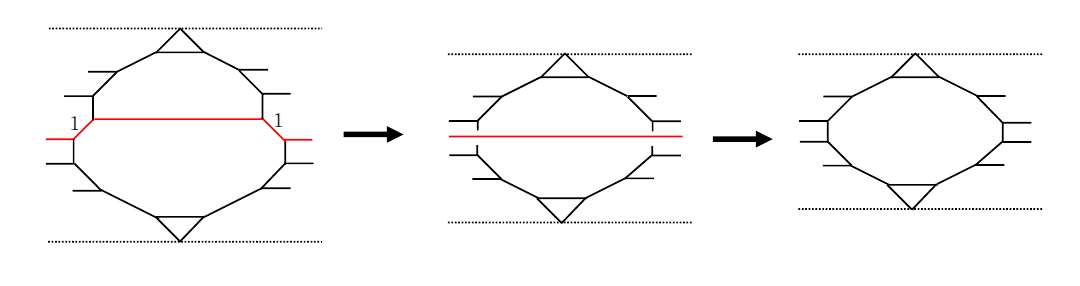
Figure 6 . A web diagram description of a usual Higgsing. By setting the Kähler parameters to 1, one can equate the Coulomb branch parameter and the fundamental masses. The D5-brane in red then can be taken to the Higgs branch directions. The resulting web diagram gives 5d N = 1 Sp (1) gauge theory with 8